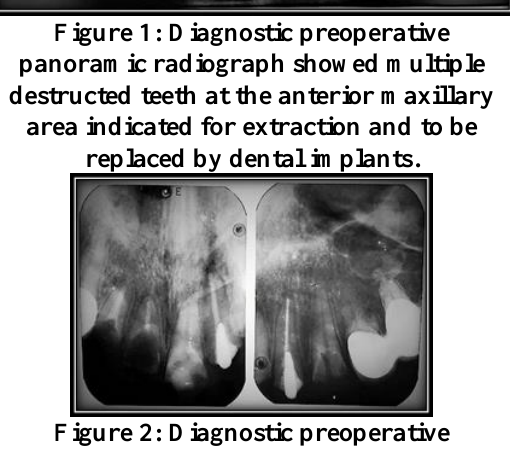
Figure 2: Diagnostic